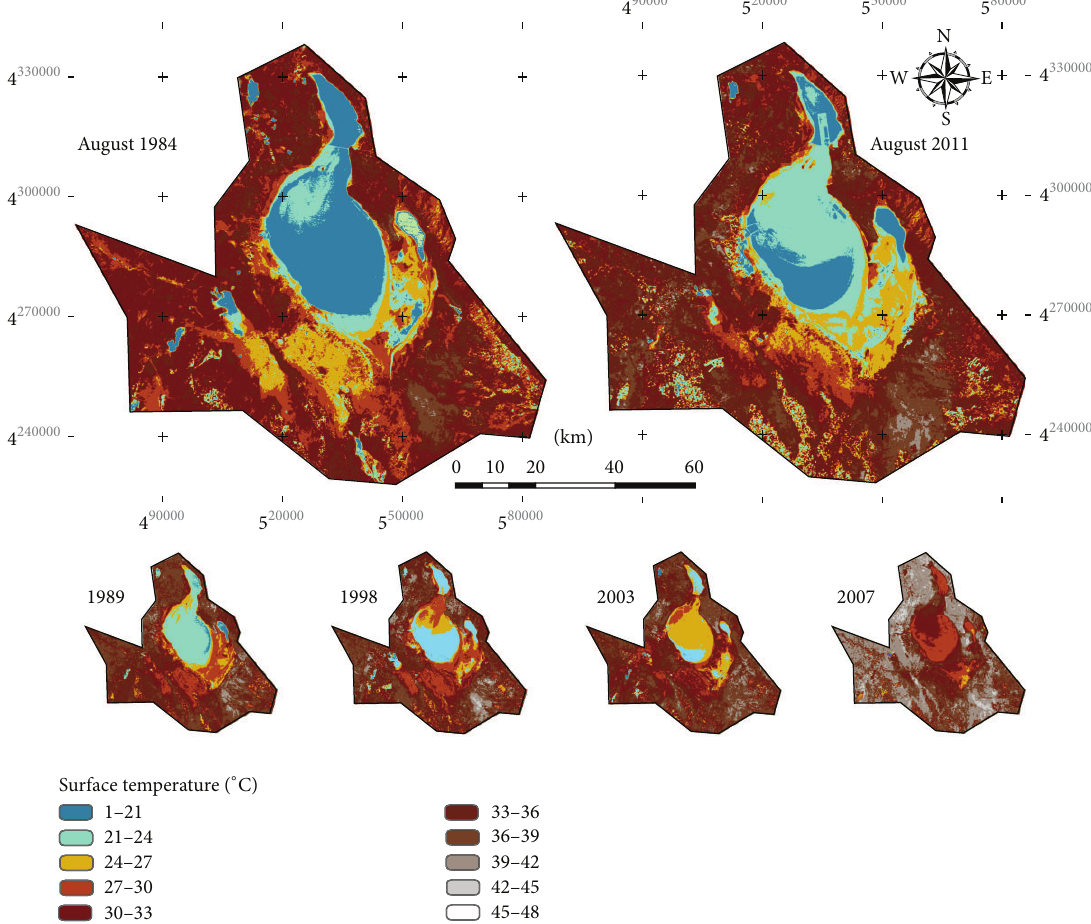
Figure 5: Interpretation of LST changes over Salt Lake Basin